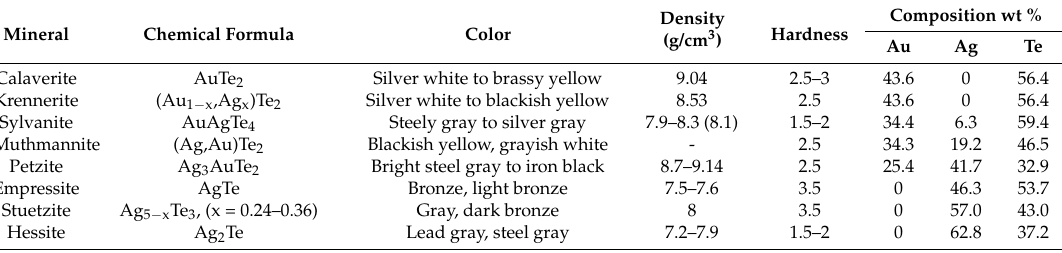
Figure 2. Projections of the crystal structures of sylvanite ( A ) and calaverite ( B ). Crystal structure data for the minerals are from references [11,20]. Table 1. Characteristics and physical properties of the main gold–(silver) tellurides.